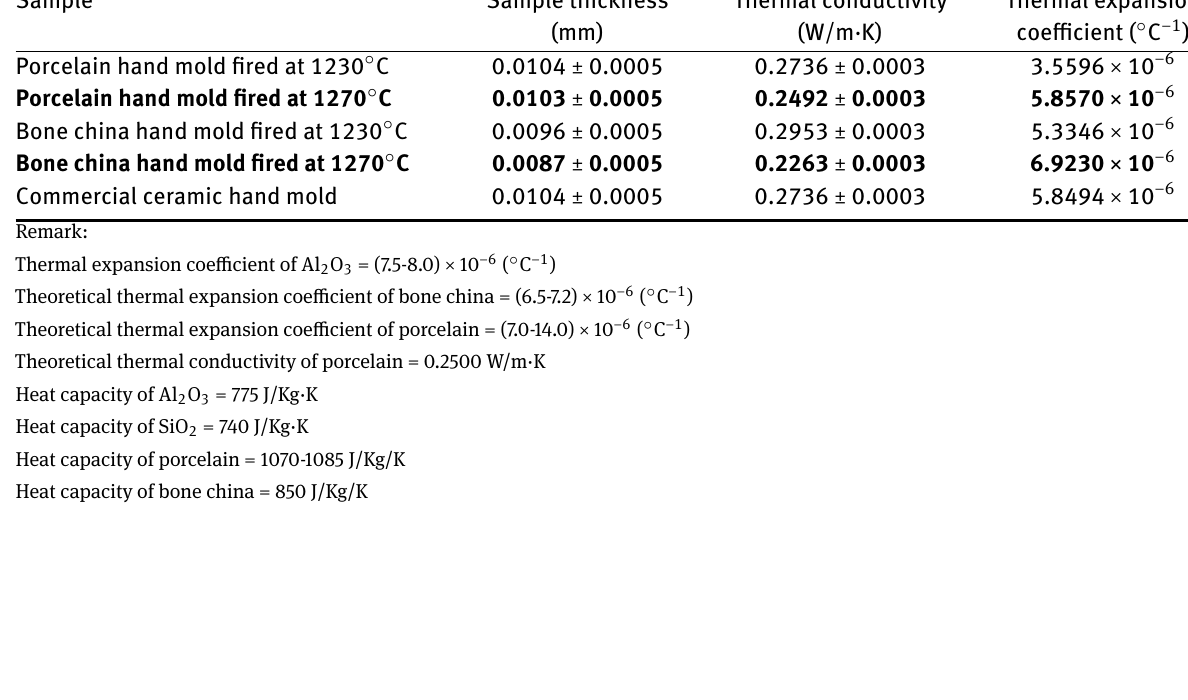
Table 7: Thermal expansion coeflcient values of porcelain, bone china and commercial ceramic hand mold samples Sample